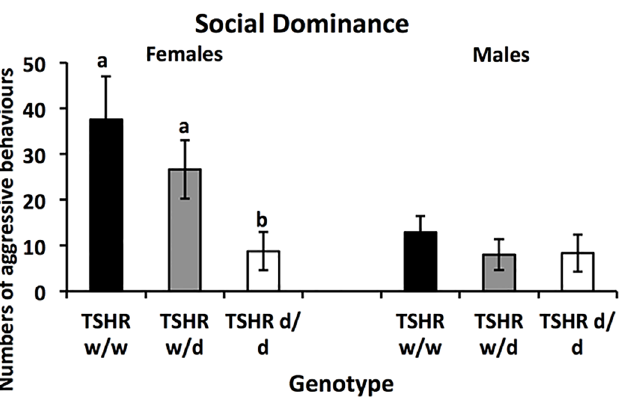
Fig 3. Average numbers of aggressive behaviours in the social dominance-test ( ± SEM) for each genotype and sex of the TSHR chickens. Post-hoc analyses females: bars designated with different letters differ significantly at P <